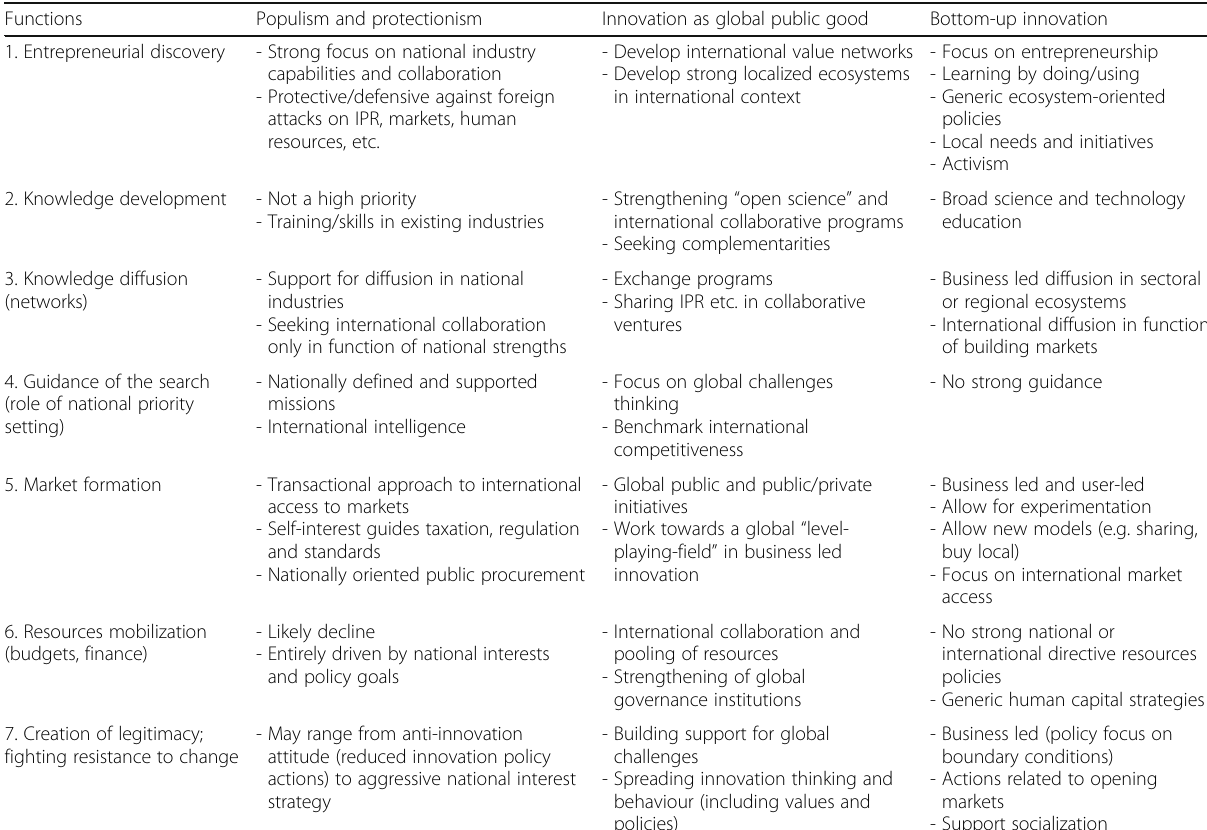
Table 2 Innovation system functions (based on the work of Hekkert et al. [48]) in the different scenarios